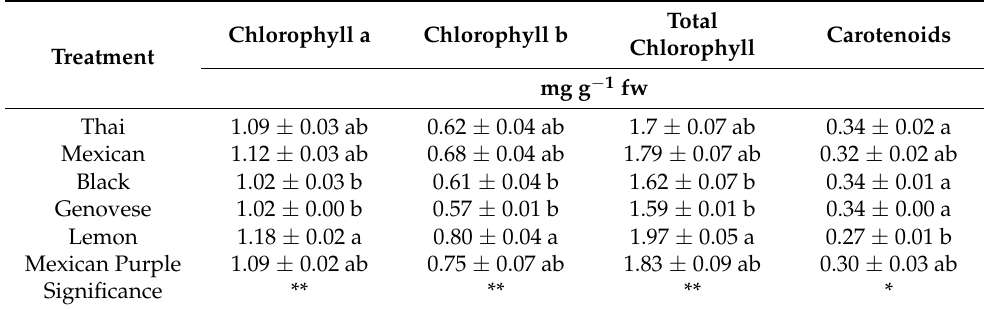
Table 3. Comparison of Thai, Mexican, Black, Genovese, Lemon, and Mexican Purple basil on leaf pigments.